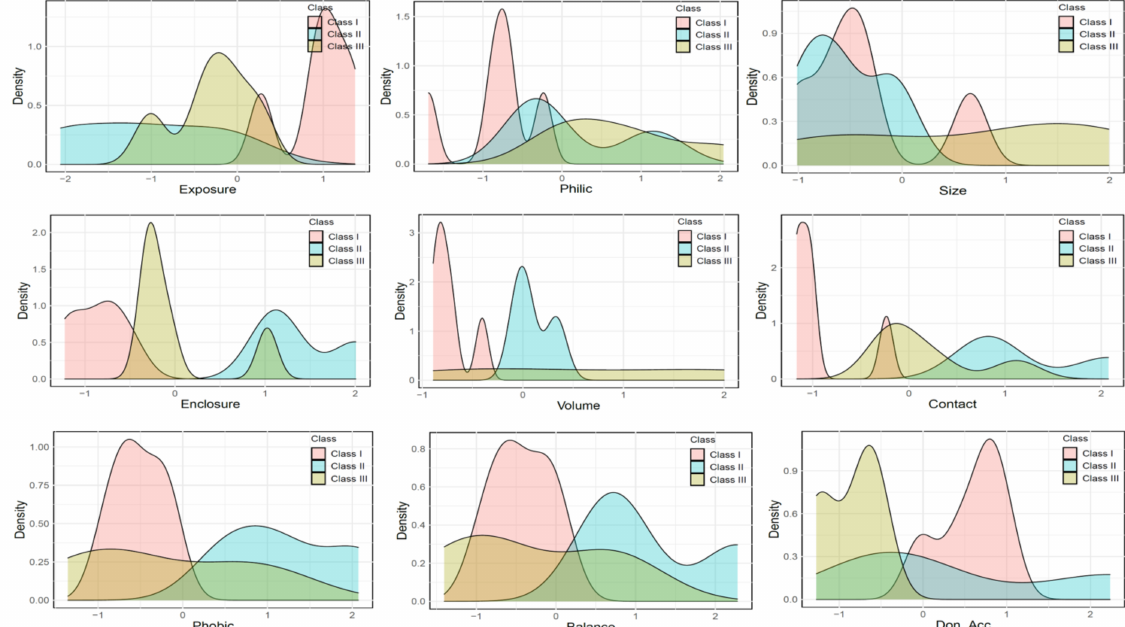
Figure 2. Probability density curves for the highly relevant SiteMap parameters of the binding pocket for three classes. The X-axis represents the SiteMap parameters, and the Y-axis represents the probability density.